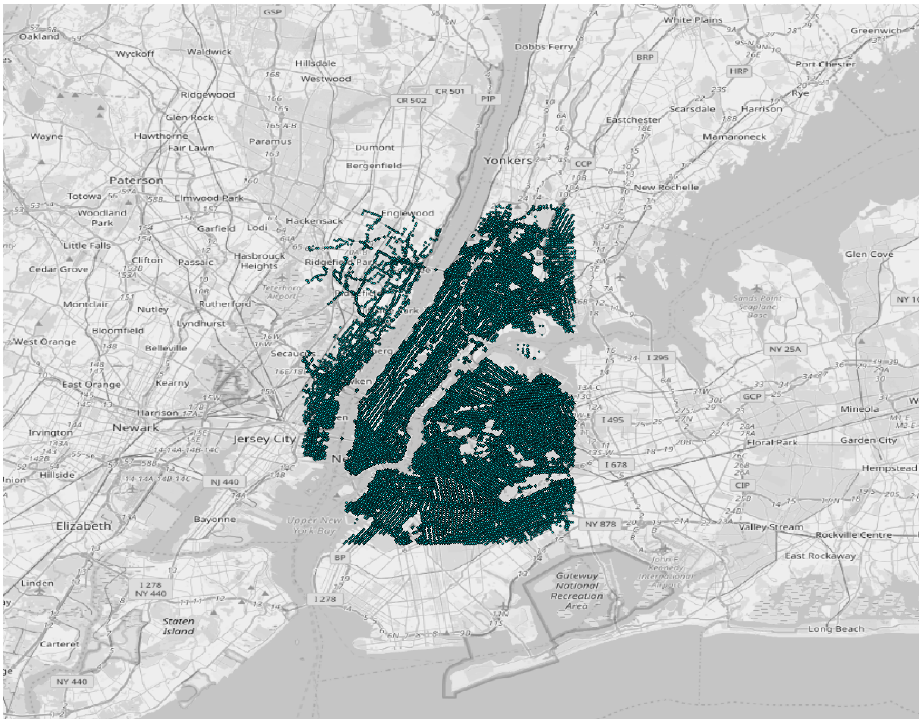
Figure 3. NYC traffic